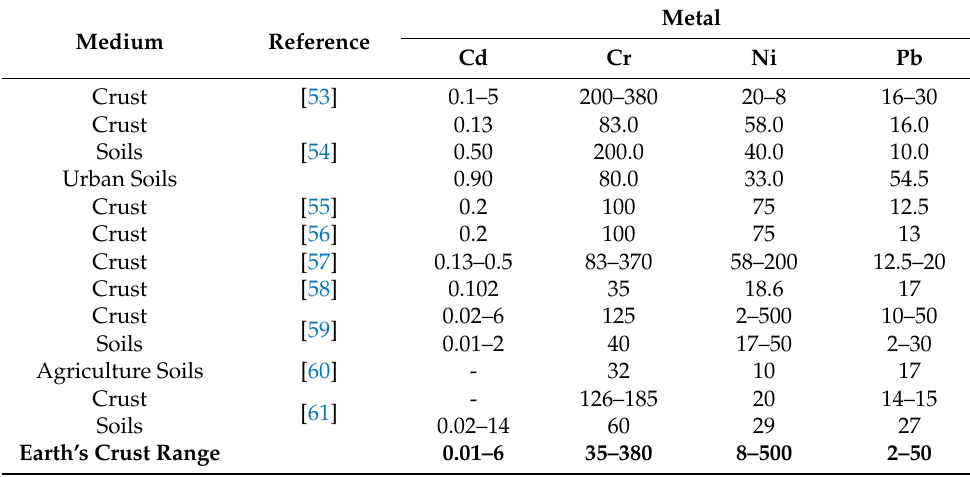
Table 4. Typical metal content in earth’s continental crust and in soil (mg/kg).